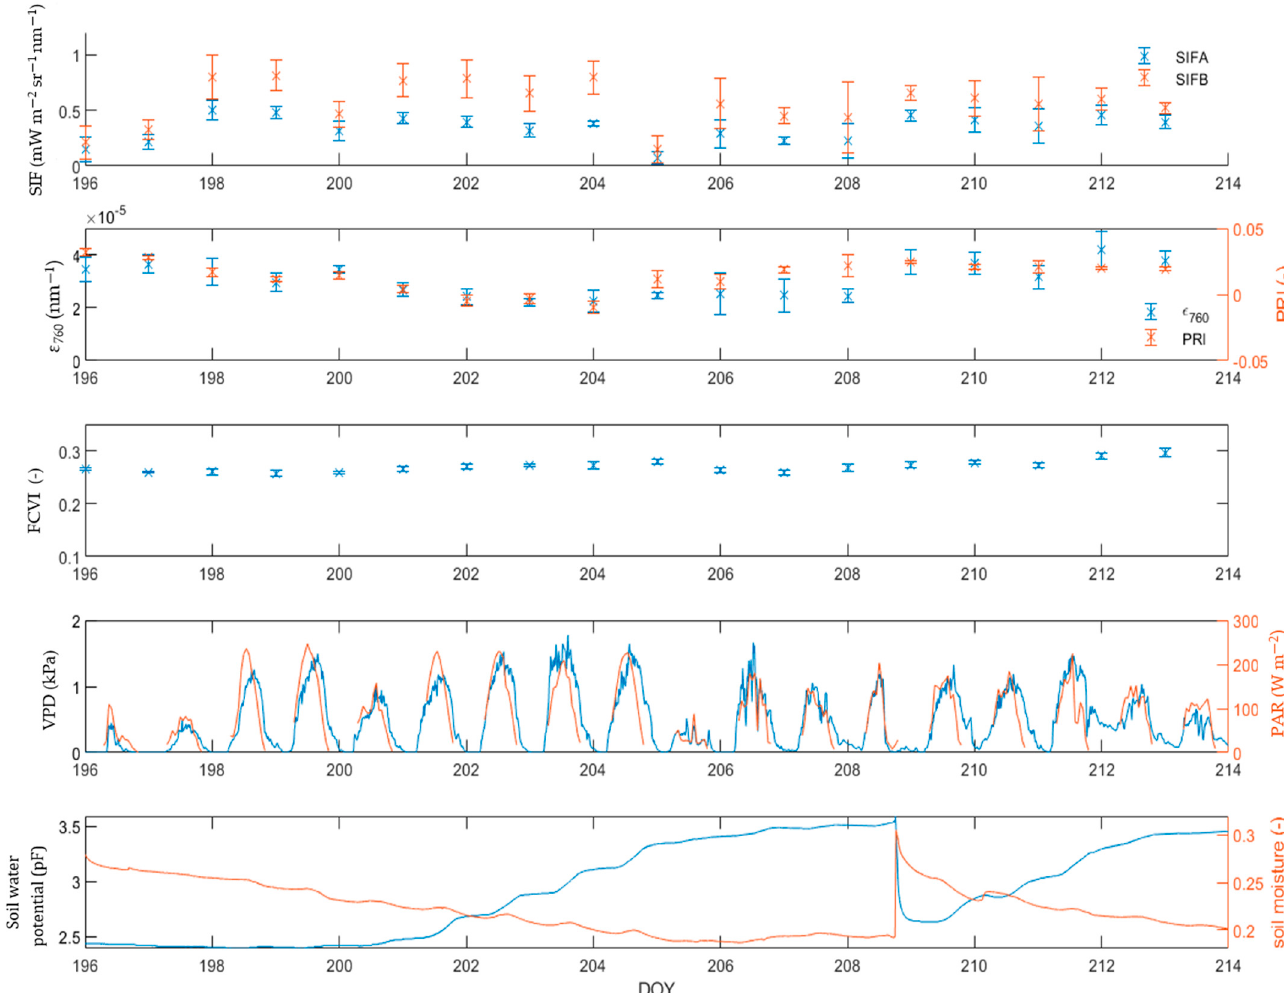
Figure 5. Evolution of SIFA, SIFB, FCVI, ϵ 760 and PRI for the 2021 mustard campaign. The drought conditions are given by the VPD, PAR, soil water potential and soil moisture.